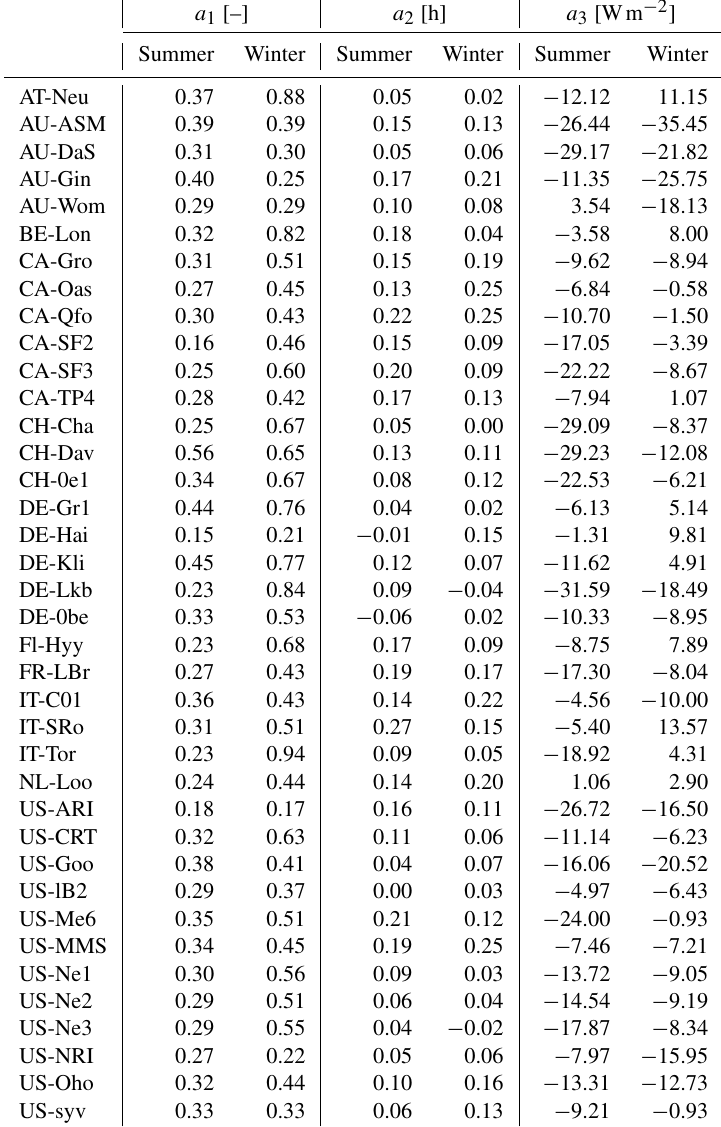
Table C2. As Table C1 but for OHM-related parameters (Sect.